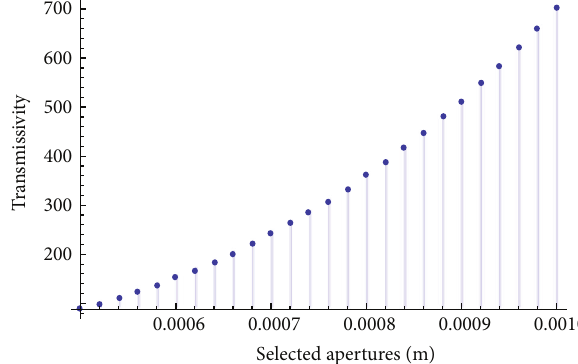
Figure 8: Selected apertures and their associated transmissivity (m 2